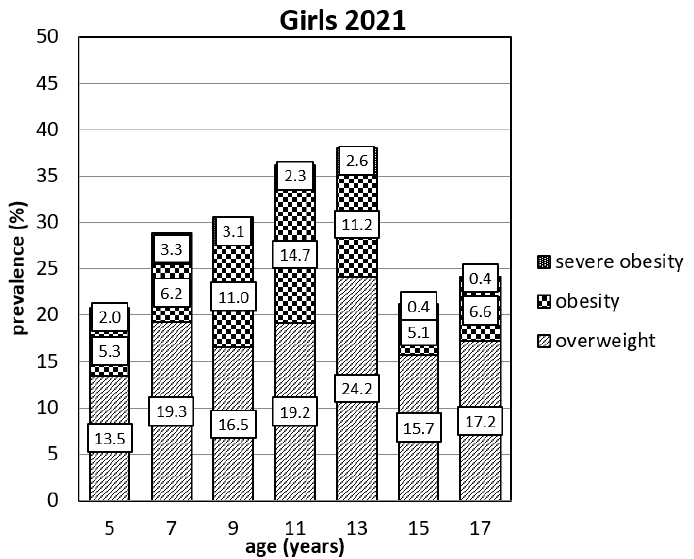
Figure 2. Prevalence of overweight, obese, and severely obese girls in 2021.